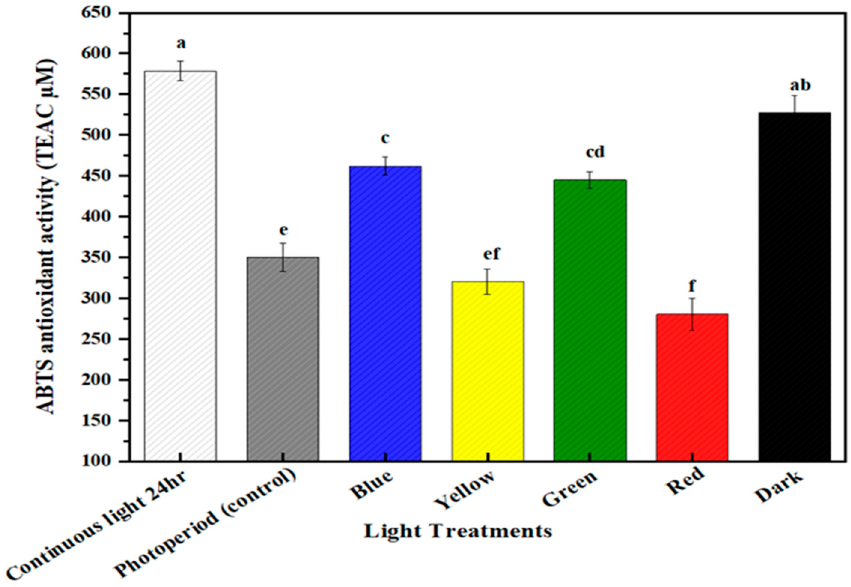
Figure 7. In vitro antioxidant ABTS activities of a callus culture of M. oleifera under different light treatments. The columns with similar letters are not statistically significant at p < 0.05.